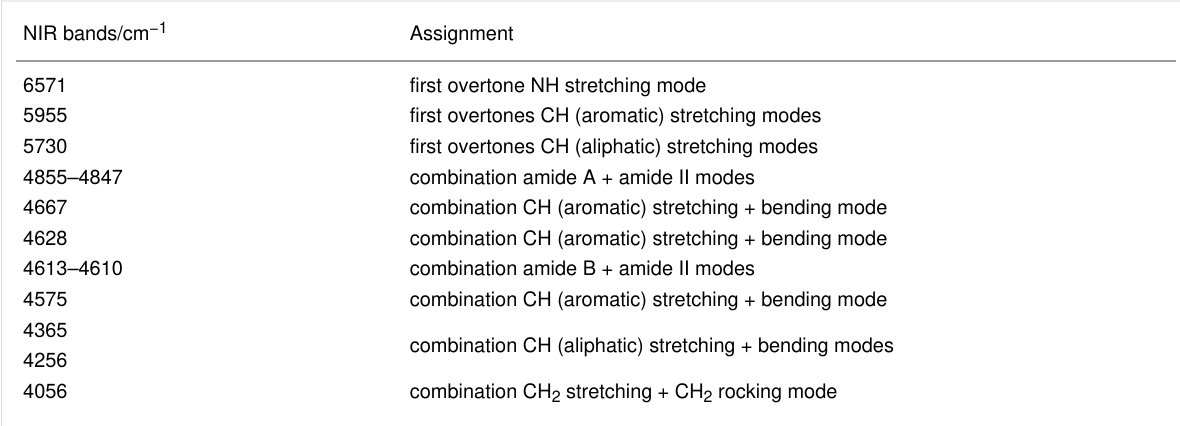
Table 1: Assignment of NIR bands of polyphenylalanine grafted on ALOX